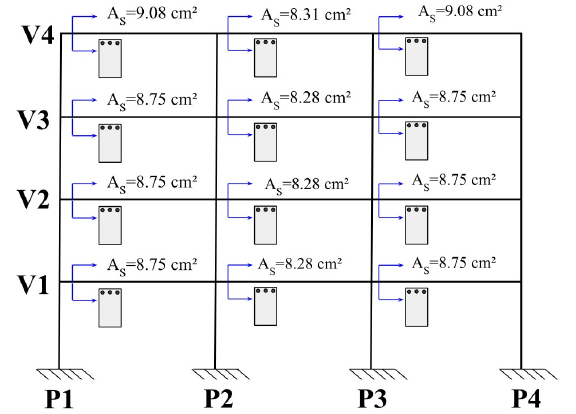
Figure 3. Steel area of the plane frame